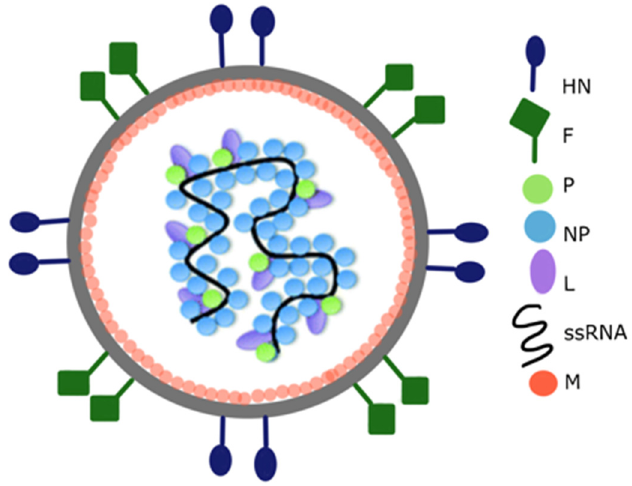
Figure 2. Graphical representation of the Newcastle disease virus particle structure. Anchored to the surface of the virus particle envelope are haemagglutinin-neuraminidase (HN) and fusion (F) glycoproteins. Matrix (M) proteins are peripherally attached to the NDV envelope. The interior of the virus particle is composed of negative-sense single-stranded RNA and RNA-associated nucleoprotein (NP), phosphoprotein (P), and large polymerase (L). Adapted from